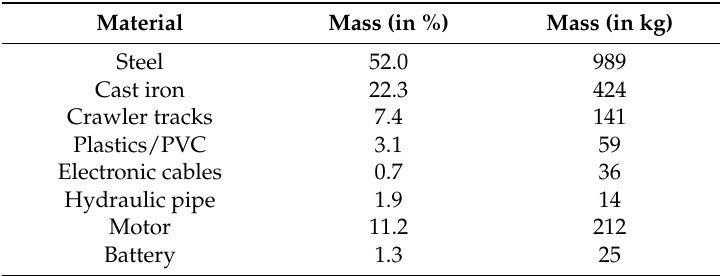
Table 2. Input data regarding the machine production of one MFC.